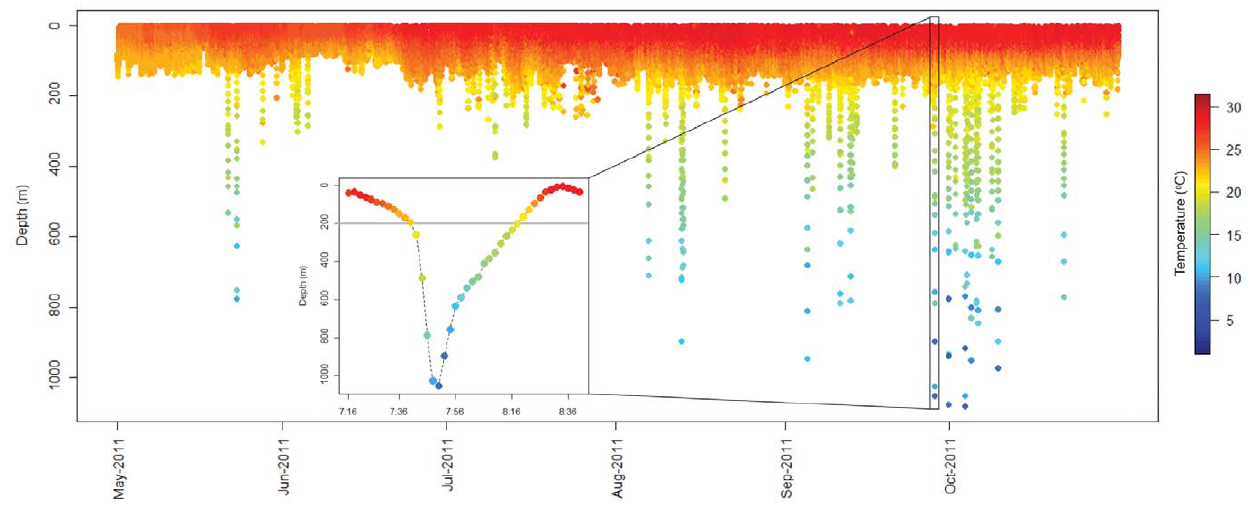
Figure 7. Chart of time-series depth (m) data with time-paired temperature ( u C) data from a recovered tag (107797; two-minute data intervals) deployed for six months. Inset depicts an example of a typical dive profile.